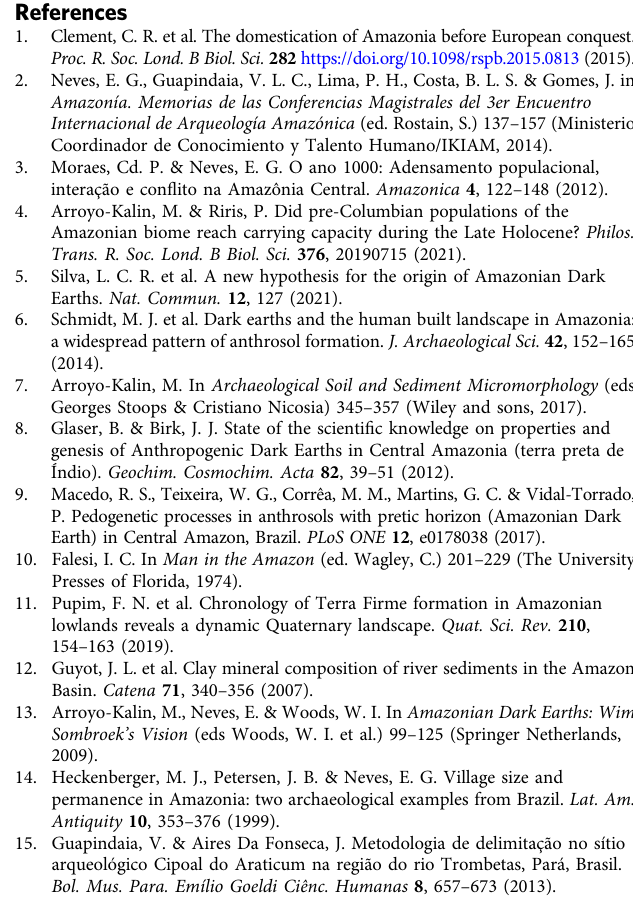
Fig. 2 Archaeological fi eldwork — excavations and mapping — carried out at the Caldeirão site in 2011. A , B , C , and D Vertical pro fi les exposed by multiple archaeological excavations at the Caldeirão ADE. E Google Earth image of the Caldeirão ADE (see location of pro fi les A – D within insets I and II). 2a and 2b are ~25 m apart and show the stratigraphy of archaeological deposits in mound (2a) and fl at (2b) areas. 2c and 2d are ~12 m apart and show the stratigraphy of archaeological deposits at an Embrapa reference pro fi le ( C ) and nearby archaeological excavation ( D ). Note clearly de fi ned archaeological matrix features in fi lled with ADE sediment ( C ), and in fi lled pit feature with well-preserved ceramic vessels, suggesting intentional deposition by ancient indigenous Amazonians ( D ). E Yellow shaded area shows the spatial distribution of mounds and archaeological pottery ascertained through archaeological survey and excavation. Insets I, II, II show details of the topography and/or archaeological excavations, as well as sampling location for pro fi les depicted in ( A – D ). Inset II: Note the close proximity between identi fi ed mounded areas (black arrows), archaeological excavations, and the area of the ADE sampled by Silva 5 (blue rectangle). Inset III: Survey has also identi fi ed mounded areas (black arrows) near the area Silva et al. 5 sampled for Ultisols (red